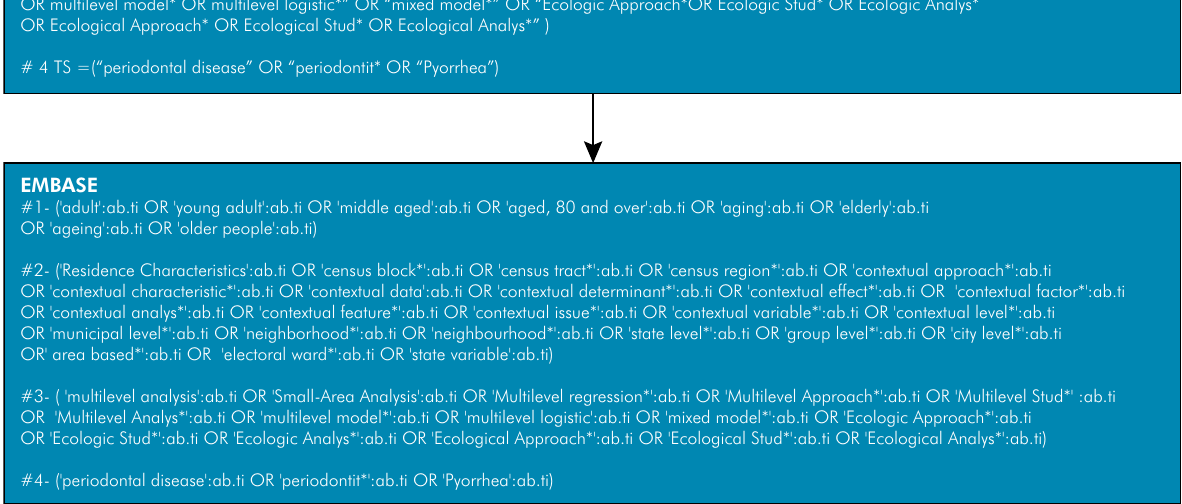
Figure 2. Search